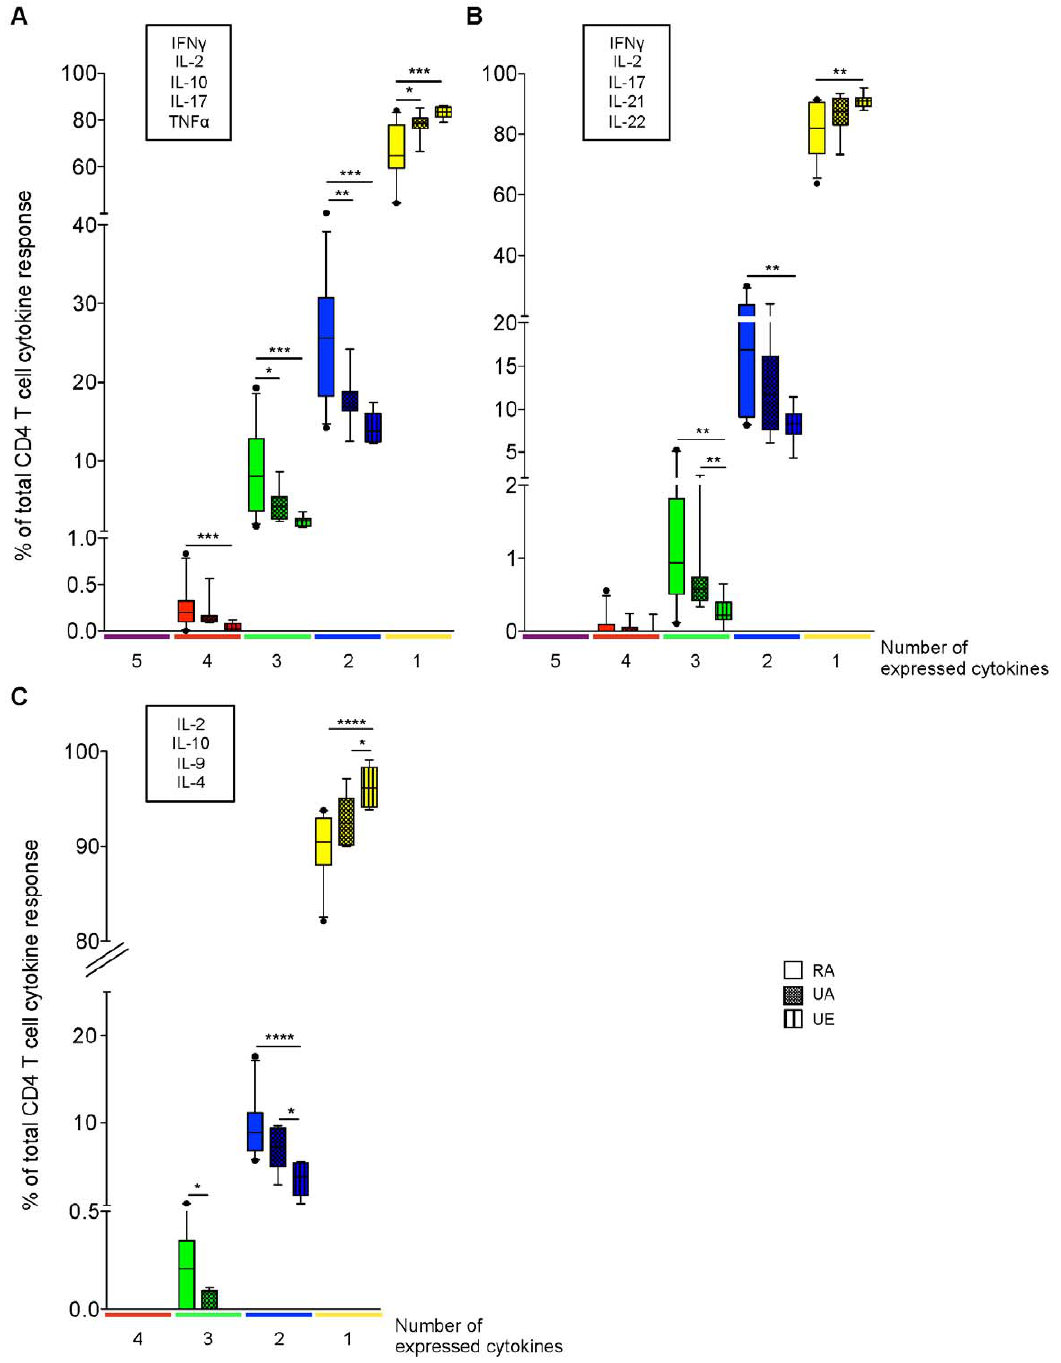
Figure 5. Rural individuals have a higher frequency of multifunctional CD4 T cells compared to urban donors. The different functional subsets of CD4 T cells (represented in Figure S3) were grouped by colour according to the number of cytokines they simultaneously express (the subsets expressing 5 cytokines are in purple, 4 in red, 3 in green, 2 in blue or 1 in yellow). For the functional profiles to be compared between the groups irrespective of any differences in frequency, the responses were normalized. The total number of CD4 T cells positive for at least one cytokine was considered as 100%. The frequency within the CD4 T cell population of the single, double, triple, quadruple and quintuple producers was calculated as a fraction of the total cytokine response by CD4 T cells and expressed as a percentage and is shown for each group of donors (rural African (RA, n=25), urban African (UA, n=8) and urban European donors (UE, n=8)) (medians (%) and 95% confidence intervals are indicated for each group). A shows the results for panel 1; B and C represent the data obtained with panel 2 and 3 (Table S1), respectively. The cytokines measured simultaneously using the different Ab panels are indicated above each plot. Differences in CD4 T cell responses across groups were tested using Kruskal-Wallis test (data not shown) and where significance was obtained, Mann-Whitney U test was used for pair-wise analysis of the differences between groups. Statistically significant P -values ( , 0.05) are indicated in (A) by an asterisk (P , 0.05 *; P # 0.01 **; P # 0.001 ***).